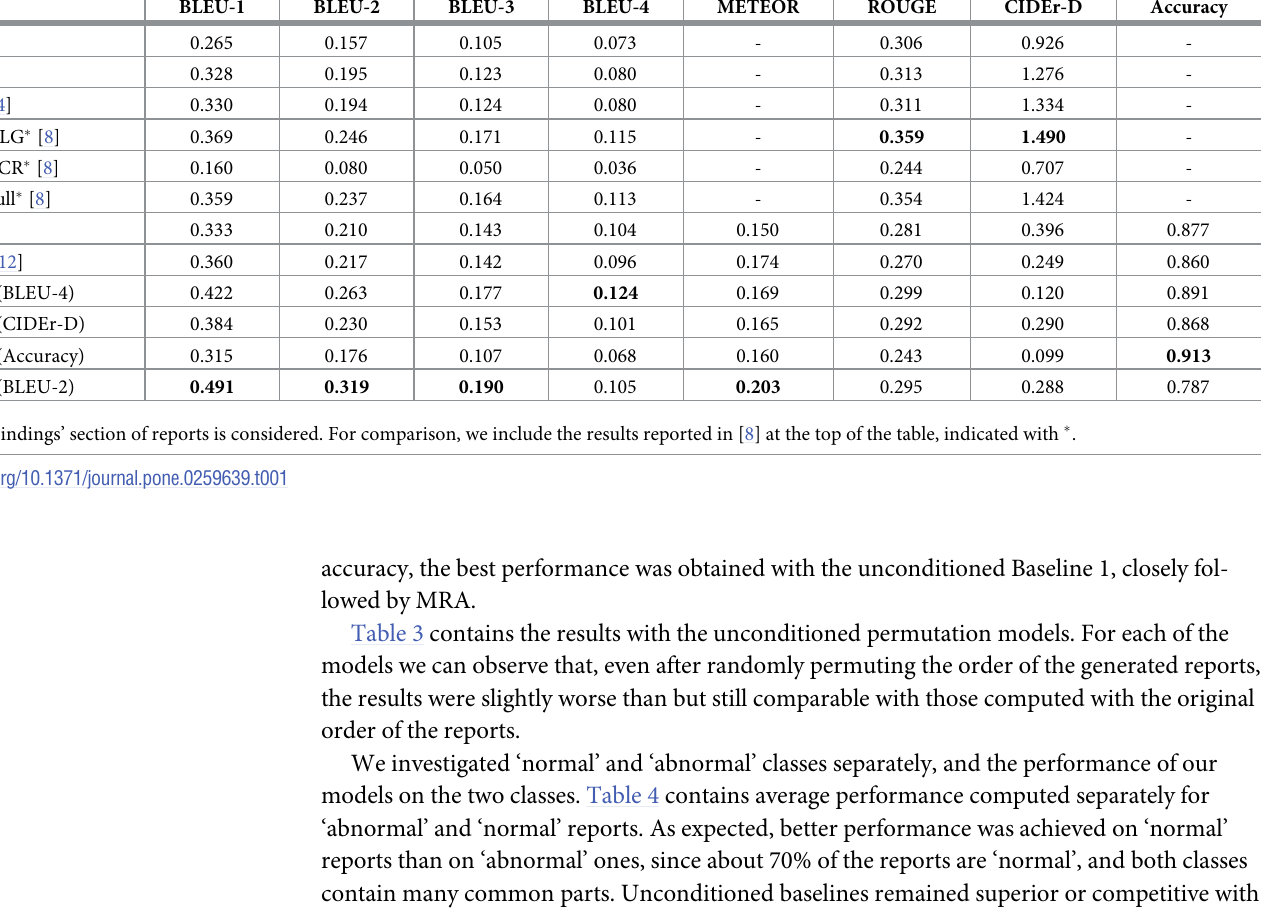
Table 1. Average performance results on the IU chest X-ray dataset over test sets. BLEU-1